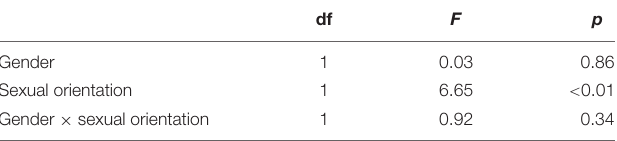
TABLE 4 | Between-subject effects of gender and sexual orientation on the IRQ.